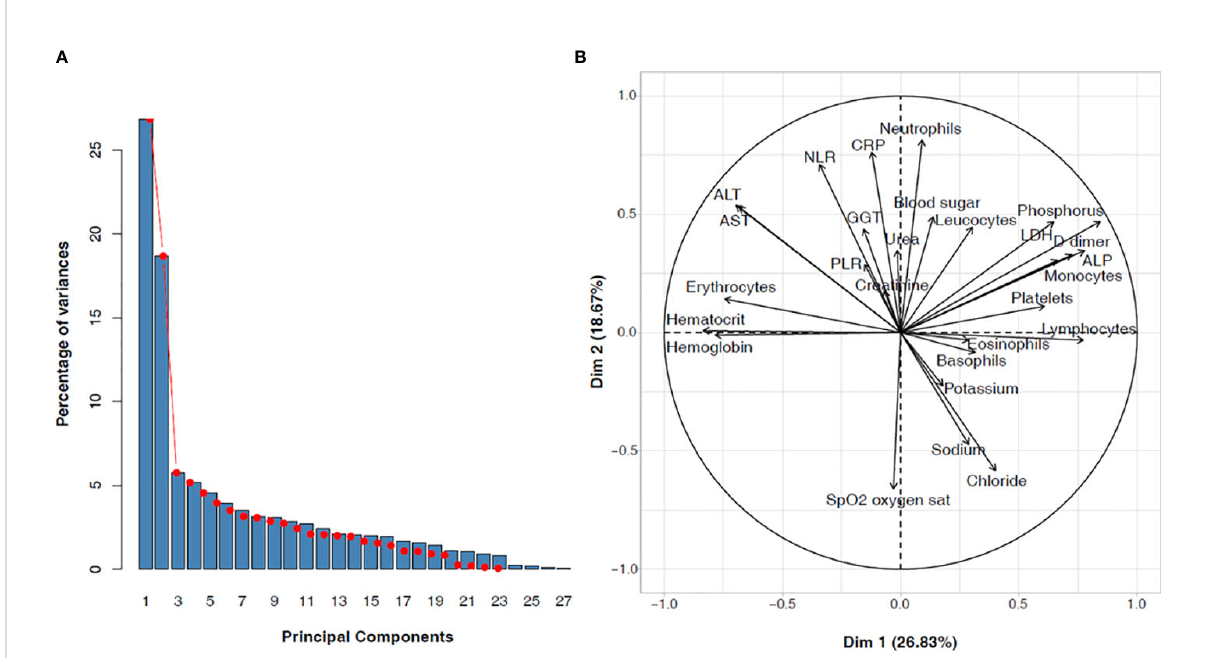
FIGURE 3 Biochemical and hematological parameters among COVID-19 Gabonese patients. (A) Principal components selected with the missMDA and FactoMineR approach (B) Weight of each variable on the principal components ALT, Alanine Aminotransferase; AST, Aspartate Aminotransferase; ALP, Alkaline phosphate; GGT, Gamma Glutamyltransferase; CRP, C-reactive protein; LDH, Lactate dehydrogenase; PLR, platelets to lymphocytes ratio; NLR, neutrophils to lymphocytes